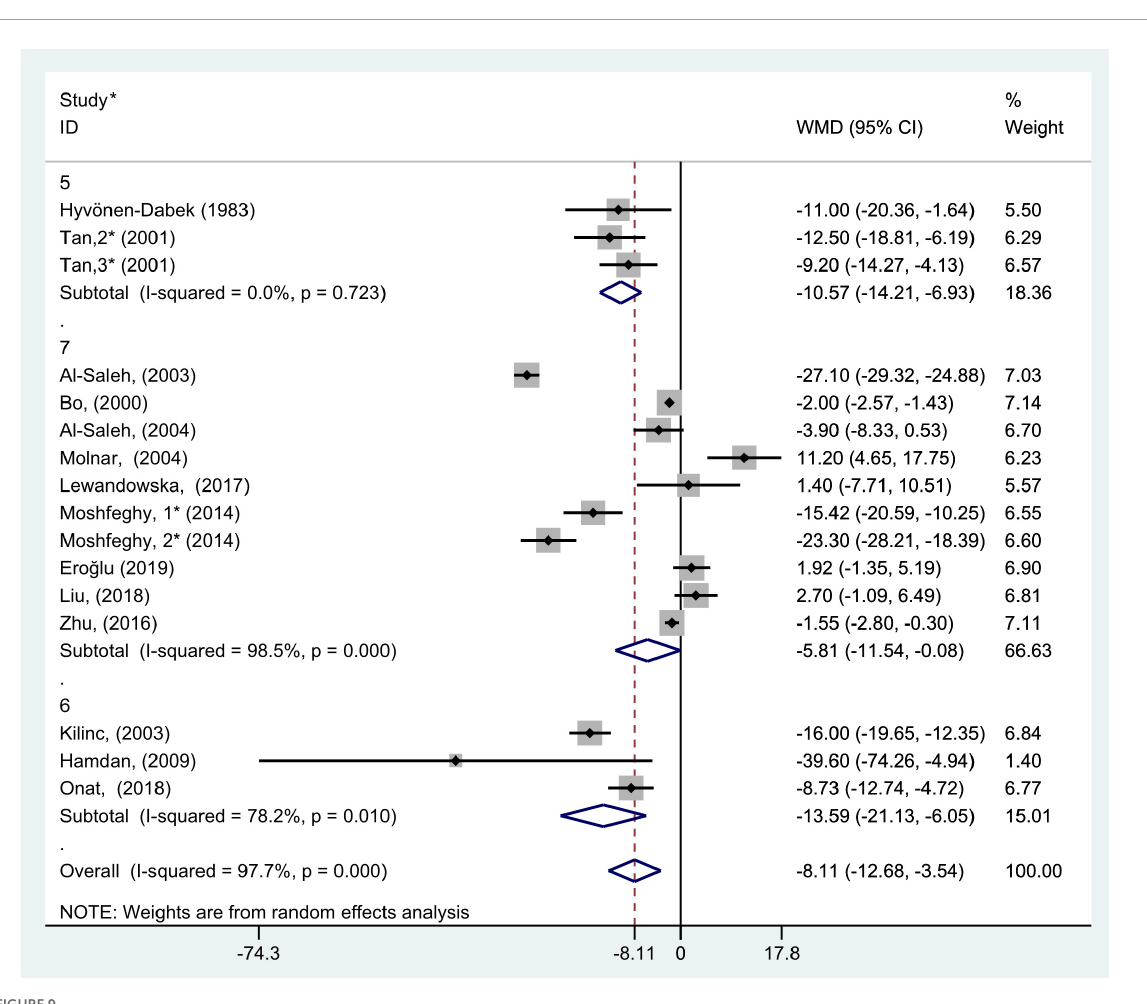
FIGURE9 Subgroup analysis of blood selenium level in patients with gestational diabetes mellitus and healthy pregnant women based on the score of study quality. The random effect model is applied. For studies in which blood selenium levels were measured during different pregnancy periods in one study, 1, 2, and 3 are used to denote measurements performed in the first, second, and third trimesters, respectively. *First author (year of study